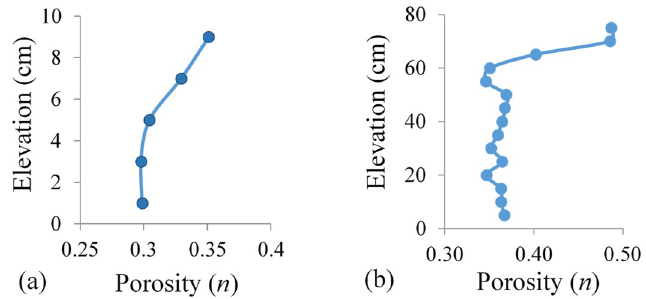
Figure 7. Variation of the porosity along the height of settled backfill for different backfilled columns: ( a ) 10 cm; ( b ) 80 cm; the elevation measured from the bottom of the columns.